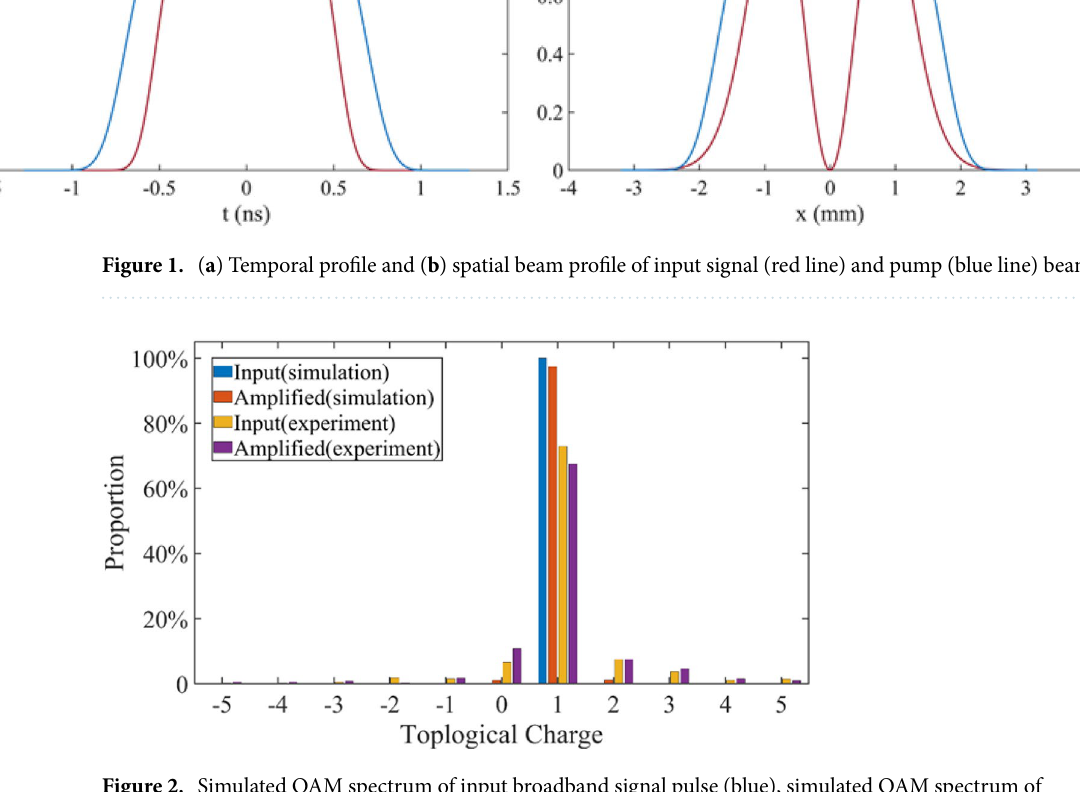
Figure 2. Simulated OAM spectrum of input broadband signal pulse (blue), simulated OAM spectrum of amplified pulse (orange), experimental input OAM spectrum (yellow), and experimental OAM spectrum after amplification